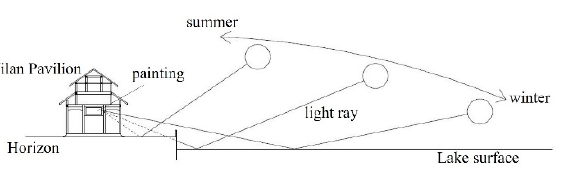
Figure 7: sunlight reflection diagram